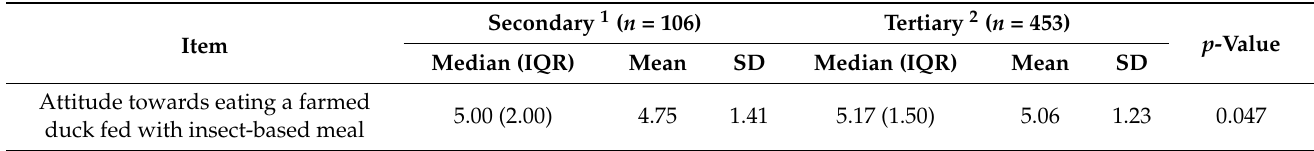
Table 4. Attitude towards, intention to purchase, and willingness to pay (WTP) for a farmed duck fed with insects, by educational level (median, IQR: interquartile range; mean, SD: standard deviation; p -value for non-parametric Mann– Whitney test for independent